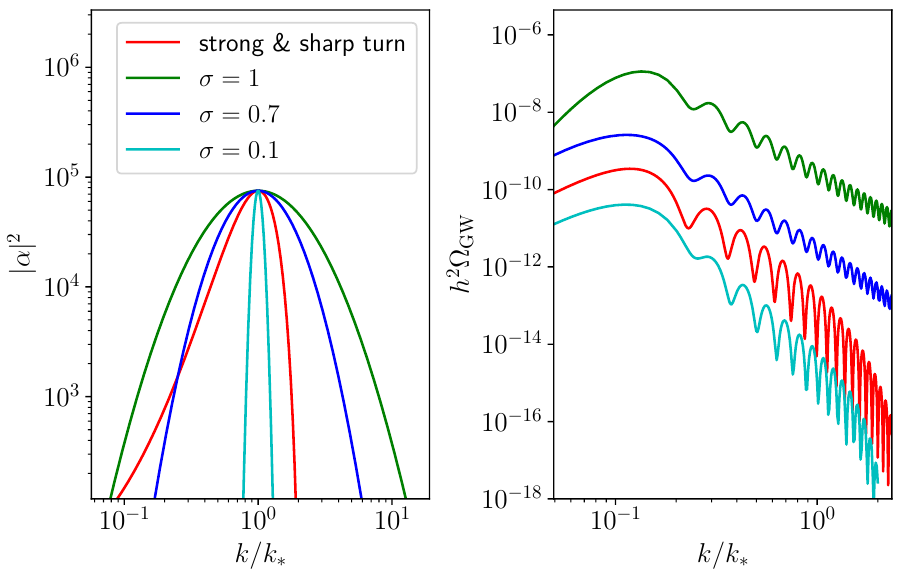
Figure 3 . Results for Ω inf , computed via (4.37), as induced by the presence of different excited GW states, characterised by different profiles of the Bogoliubov coefficients, with | α | 2 ’ | β | 2 (cid:29) 1 . Here (cid:2) (cid:3) we consider | α ( k ) | 2 = α 2 exp − 1 ln 2 ( k/k ∗ ) for different values of σ and we took Ph( β/α ) = 0 for 2 σ 2 simplicity, and we also include | α | 2 and Ω inf from the example 4.7 with ( η ⊥ , δ ) = (28 , 0 . 25) (red). GW The main finding is that the principal properties of Ω inf are independent of the precise shape of GW | α ( k ) | 2 , i.e. Ω inf exhibits a peak at k ∼ k out (cid:28) k ∗ and a UV tail modulated by O (1) oscillations GW with frequency ω = 2 /k out . Although the precise fall-off of the GW spectrum in the UV depends on the shape of the Bogoliubov coefficients, its behaviour is still universal under the (motivated) assumption that the latter are peaked around k ∗ . In fact, for the two examples with the narrowest peaks in | α ( k ) | 2 one can check that the GW spectra become near-identical and only differ by a numerical